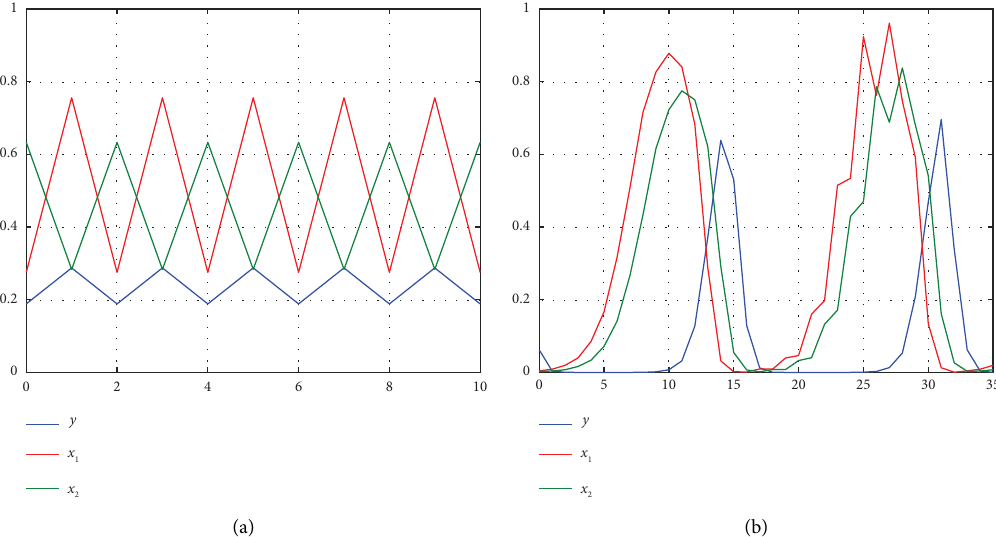
Figure 13: (a) Stable 2-cycles. ( μ